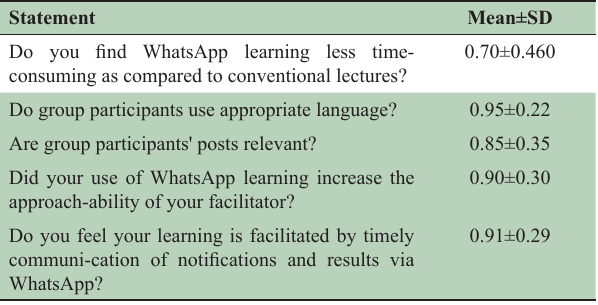
Table II: Perception of students regarding instructional aspects shown as